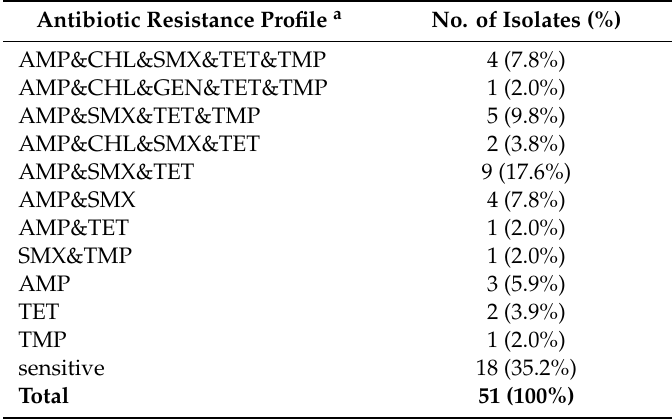
Table 3. Antimicrobial resistance phenotypes of Salmonella isolated from pig manure. Antibiotic Resistance Profile a